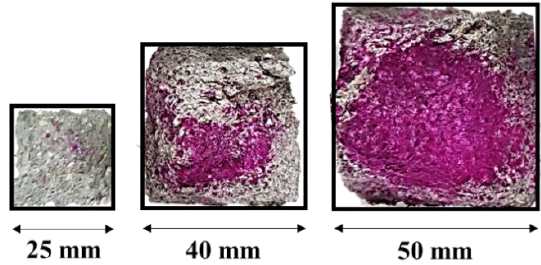
Figure 5. Carbonation depth of Mortar (W / C = 0.5) cured in 20% concentration CO 2 for 28 days.